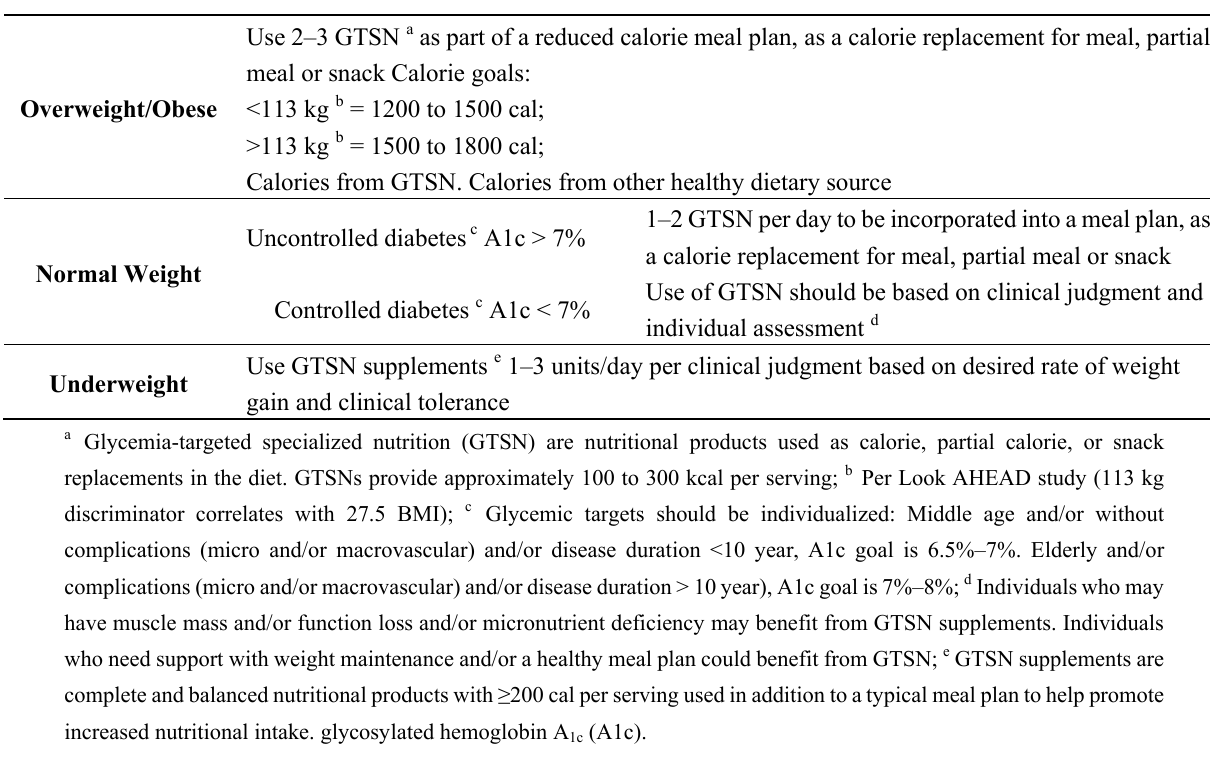
Table 6. Glycemia-targeted specialized nutrition (GTSN) for the management of prediabetes and diabetes